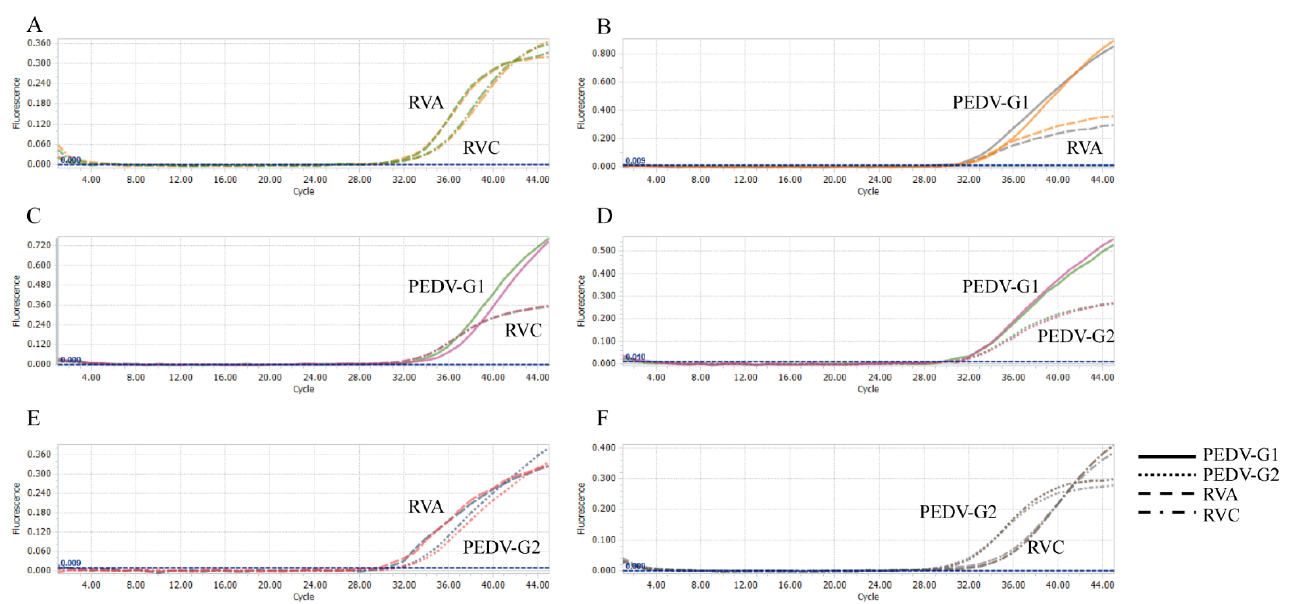
Figure 3. Co-infection simulation experiments with two pathogens. ( A ) amplification curves (X-axis: cycle, Y-axis: fluorescence) of RVA and RVC at concentrations of the LOD. ( B ) amplification curves (X-axis: cycle, Y-axis: fluorescence) of PEDV-G1 and RVA at concentrations of the LOD. ( C ) ampli- fication curves (X-axis: cycle, Y-axis: fluorescence) of PEDV-G1 and RVC at concentrations of the LOD. ( D ) amplification curves (X-axis: cycle, Y-axis: fluorescence) of PEDV-G1 and PEDV-G2 at concentrations of the LOD. ( E ) amplification curves (X-axis: cycle, Y-axis: fluorescence) of PEDV-G2 and RVA at concentrations of the LOD. ( F ) amplification curves (X-axis: cycle, Y-axis: fluorescence) of PEDV-G2 and RVC at concentrations of the LOD.